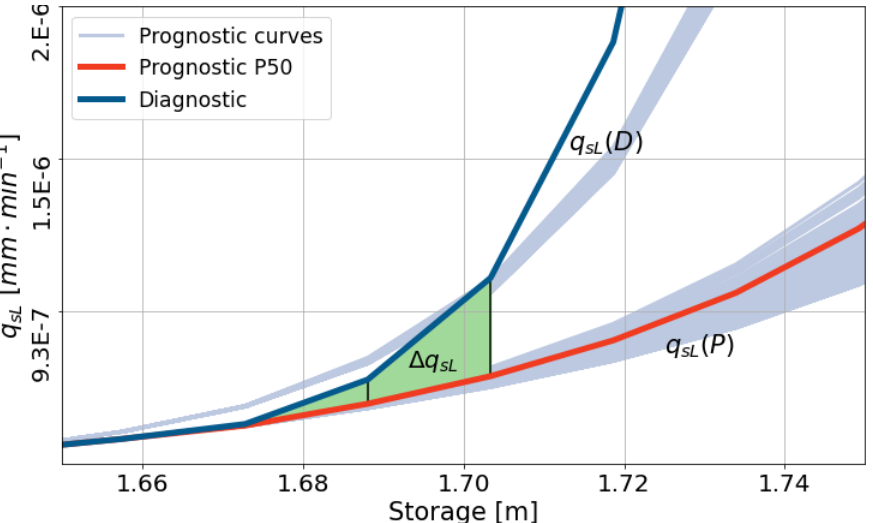
Figure 13. Example of the q sL parameterization comparison between the diagnostic and prognostic scenarios. The light blue lines are q sL curves of the prognostic scenario for a given watershed. The red line corresponds to the 50th percentile of the prognostic q sL curves. The dark blue line is the q sL curve of the diagnostic scenario. We used the green region to perform a comparison between the scenarios.